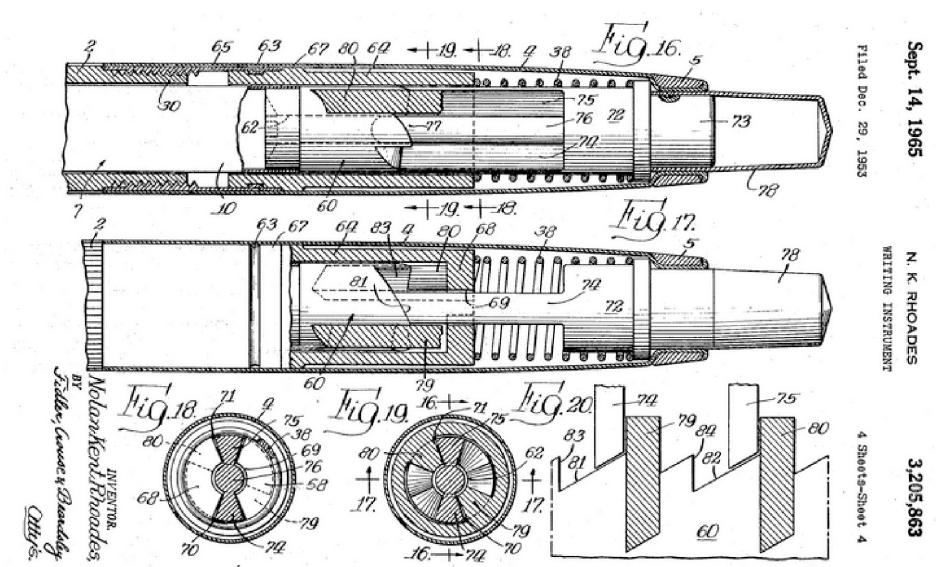
Fig 3. Click-pen mechanism of a ballpoint pen. Illustration of one of the first patented click-pen mechanisms (Parker Pen Co Ltd) [31].